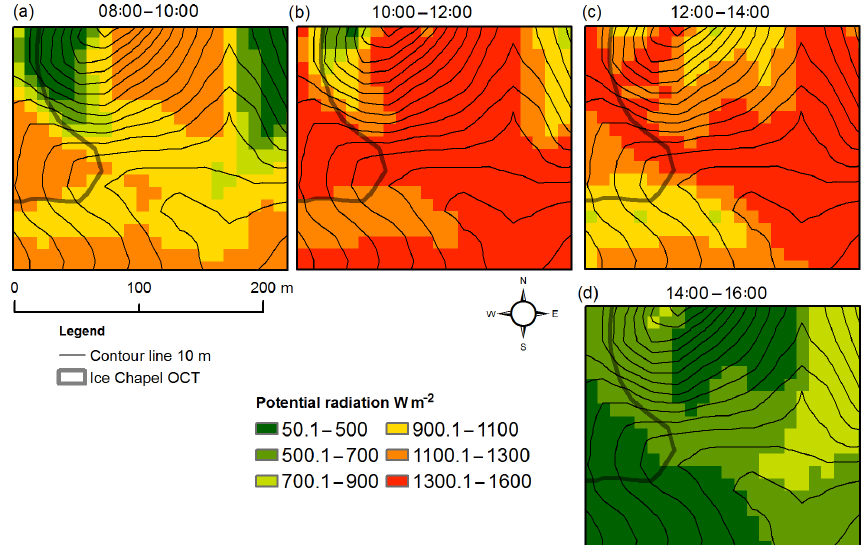
Figure 11. Potential shortwave radiation for 19 July 2018 at (a) 08:00–10:00, (b) 10:00–12:00, (c) 12:00–14:00, and (d)